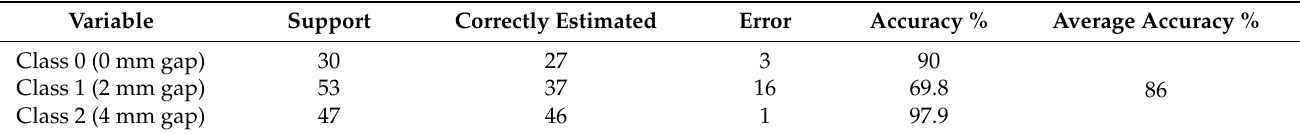
Table 9. Real-time weld gap detection performance of the proposed DNN model (decreasing gap). Variable Support Correctly Estimated